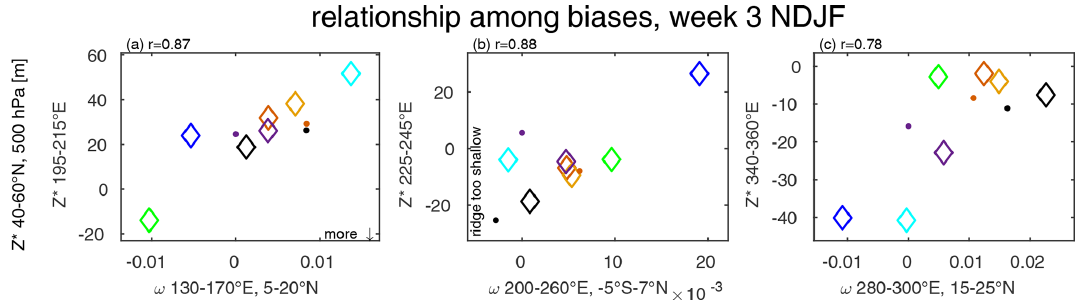
Figure 9. Summary of relationship among mid-latitude (40–60 ◦ N) regional biases of 500hPa Z ∗ over (a) the northwestern Pacific (195– 215 ◦ E) and ω over the subtropical western Pacific (5–20 ◦ N, 130–170 ◦ E), (b) western North America (225–245 ◦ E) and 500hPa ω over the tropical eastern Pacific (5 ◦ S–7 ◦ N, 200–260 ◦ E), and (c) the North Atlantic (340–360 ◦ E) and ω over the Caribbean (15–25 ◦ N, 280–300 ◦ E); r denotes the correlation between indices; dots are for older versions of ECMWF, UKMO, and CNRM; and all correlations are significant at the 95% level. Note that for panel (a) , we focus on the eastward extension of the North Pacific low, which differs more dramatically among the models, rather than the northwestern Pacific low itself, which is better represented by the